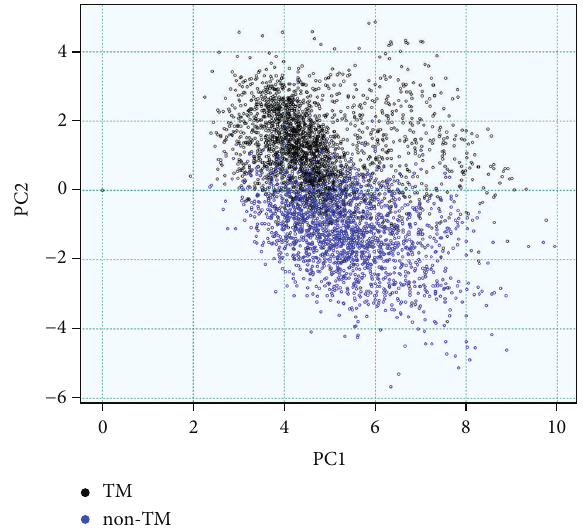
Figure 3: Principal component analysis. The transmembrane (black) and nontransmembrane (blue) segments form two different clusters.